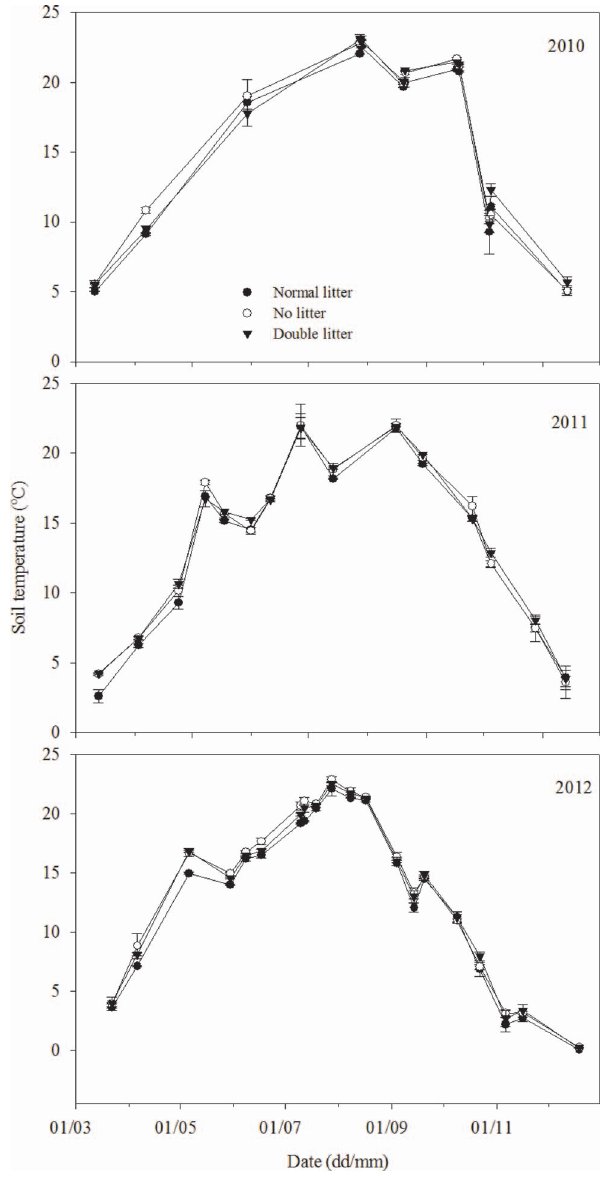
Figure 2. Variation in soil temperature ( ˚ C) at a depth of 5 cm for different litter treatments, including normal litter, no litter, and double litter treatments in 2010, 2011, and 2012, respectively. The asterisk indicates a significant difference at P ,